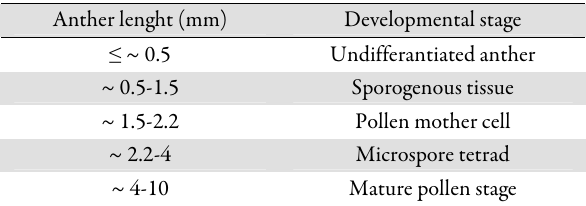
Table 1 . Correlation between anther lenght and developmental stage in H. annuus L.